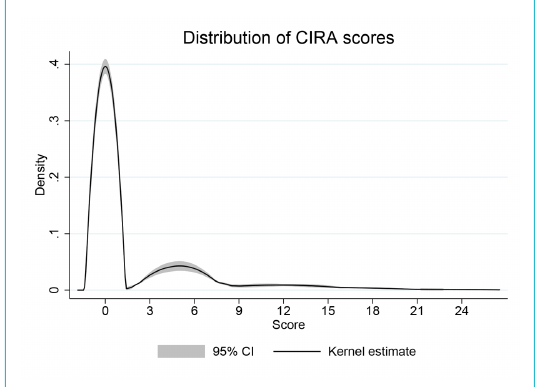
Figure 1: Distribution of CIRA scores in the development sample (n = 365). Kernel density with adaptive estimator.